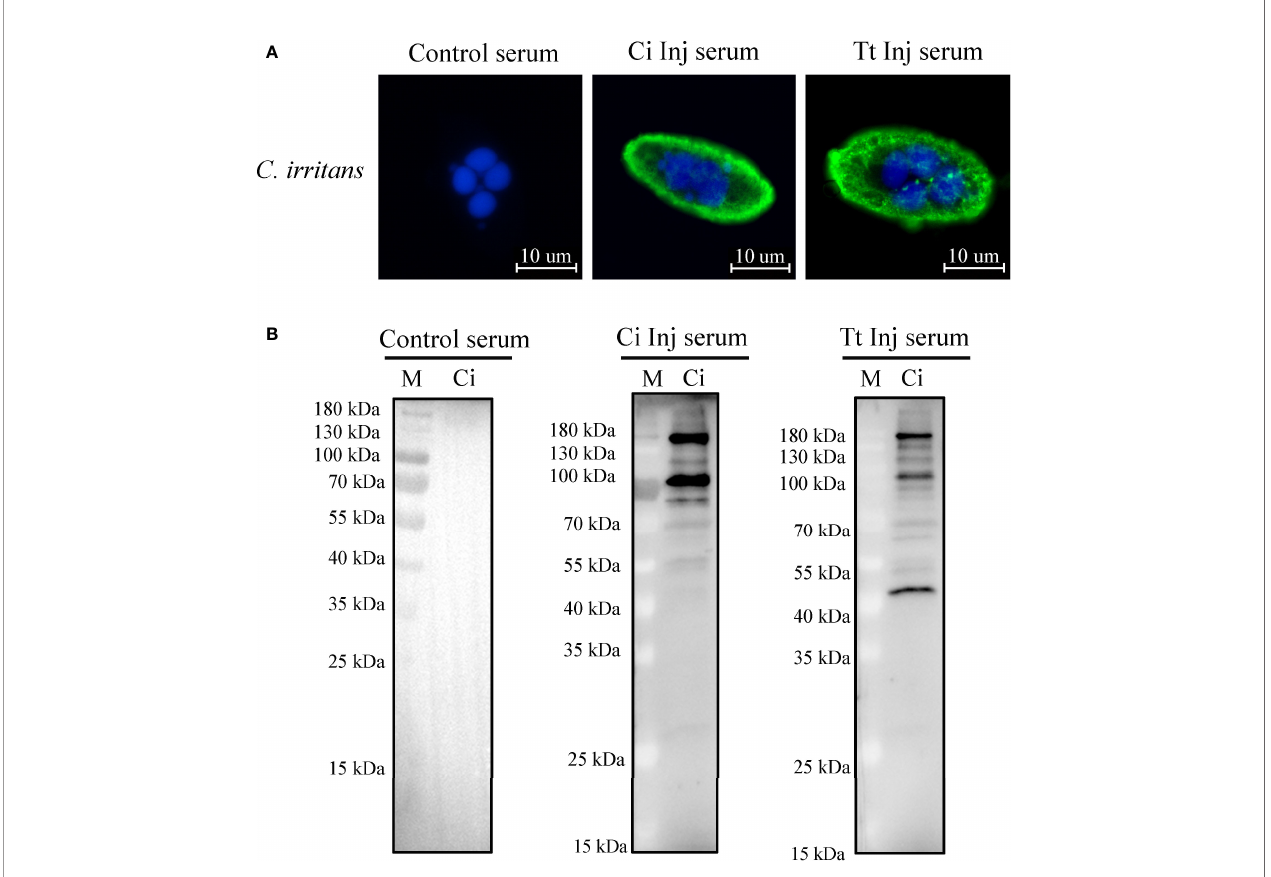
FIGURE 3 | Identi fi cation of cross-reactive antigens between C. irritans and T. thermophila . (A) Immuno fl uorescence staining of C. irritans using serum from C. irritans – or T. thermophila – immunized grouper. (B) Western blot analysis of total protein from C. irritans and T. thermophila using serum from immunized